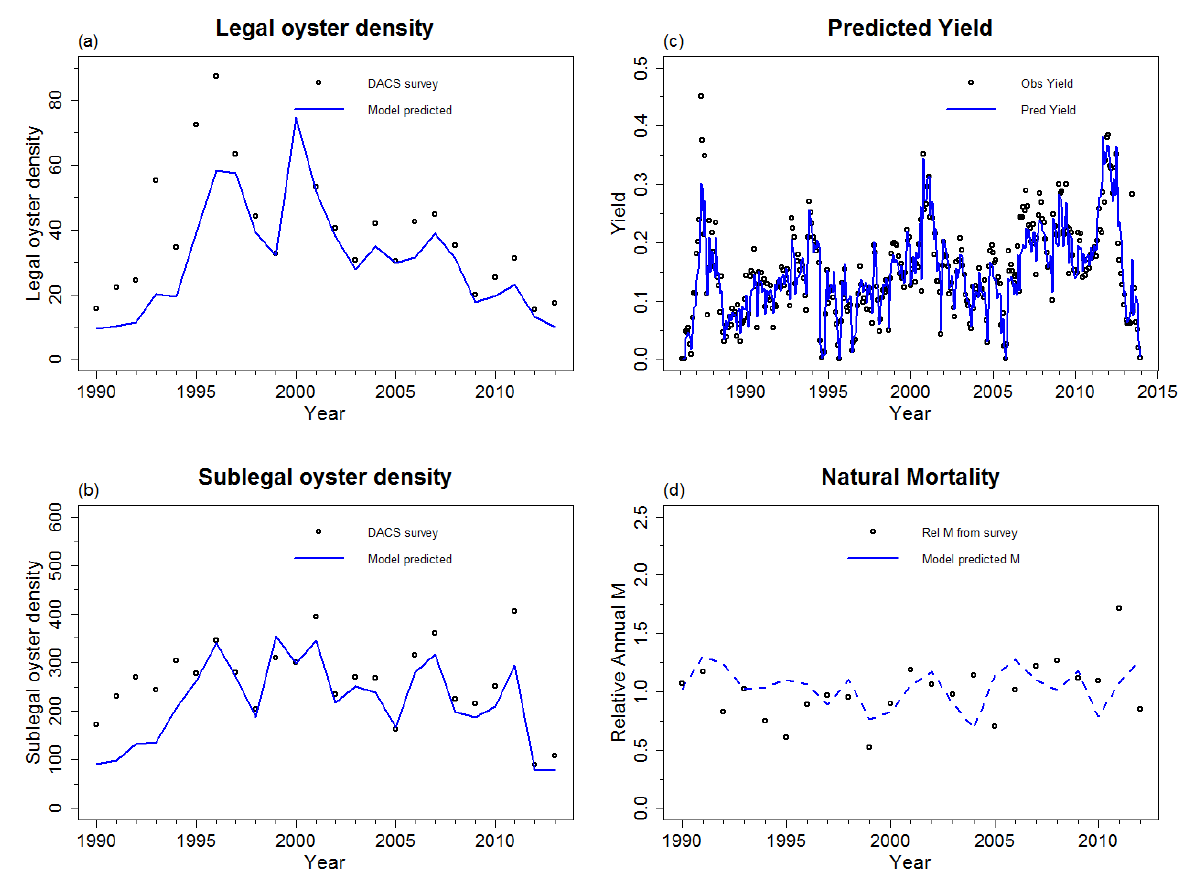
Figure A2.3. Observed (black circles) and model predicted (blue line) trends in legal (> 76.2 mm, panel (a) and sub-legal (b) oyster abundance, predicted oyster fishery yield (c), and estimated natural mortality rate (d) in Apalachicola Bay from 1990-2013. Model prediction results are from applying the parameter estimation procedure assuming balanced impacts of variation in natural mortality rate and recruitment rate. Observed data are from Florida Department of Agriculture and Consumer Sciences (DACS) fisheries independent surveys and predictions are from age-structured model described in this paper for comparison. Note large reduction in recruitment rates for 2012-3 implied by forcing the model to fit the DACS density